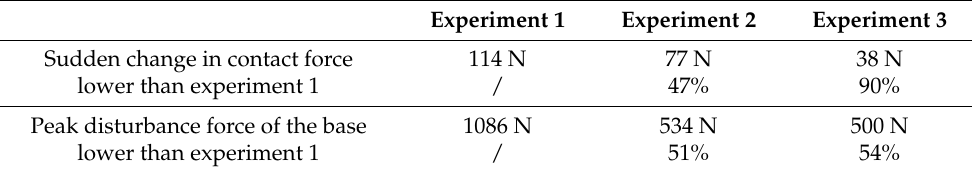
Table 3. The comparison between the